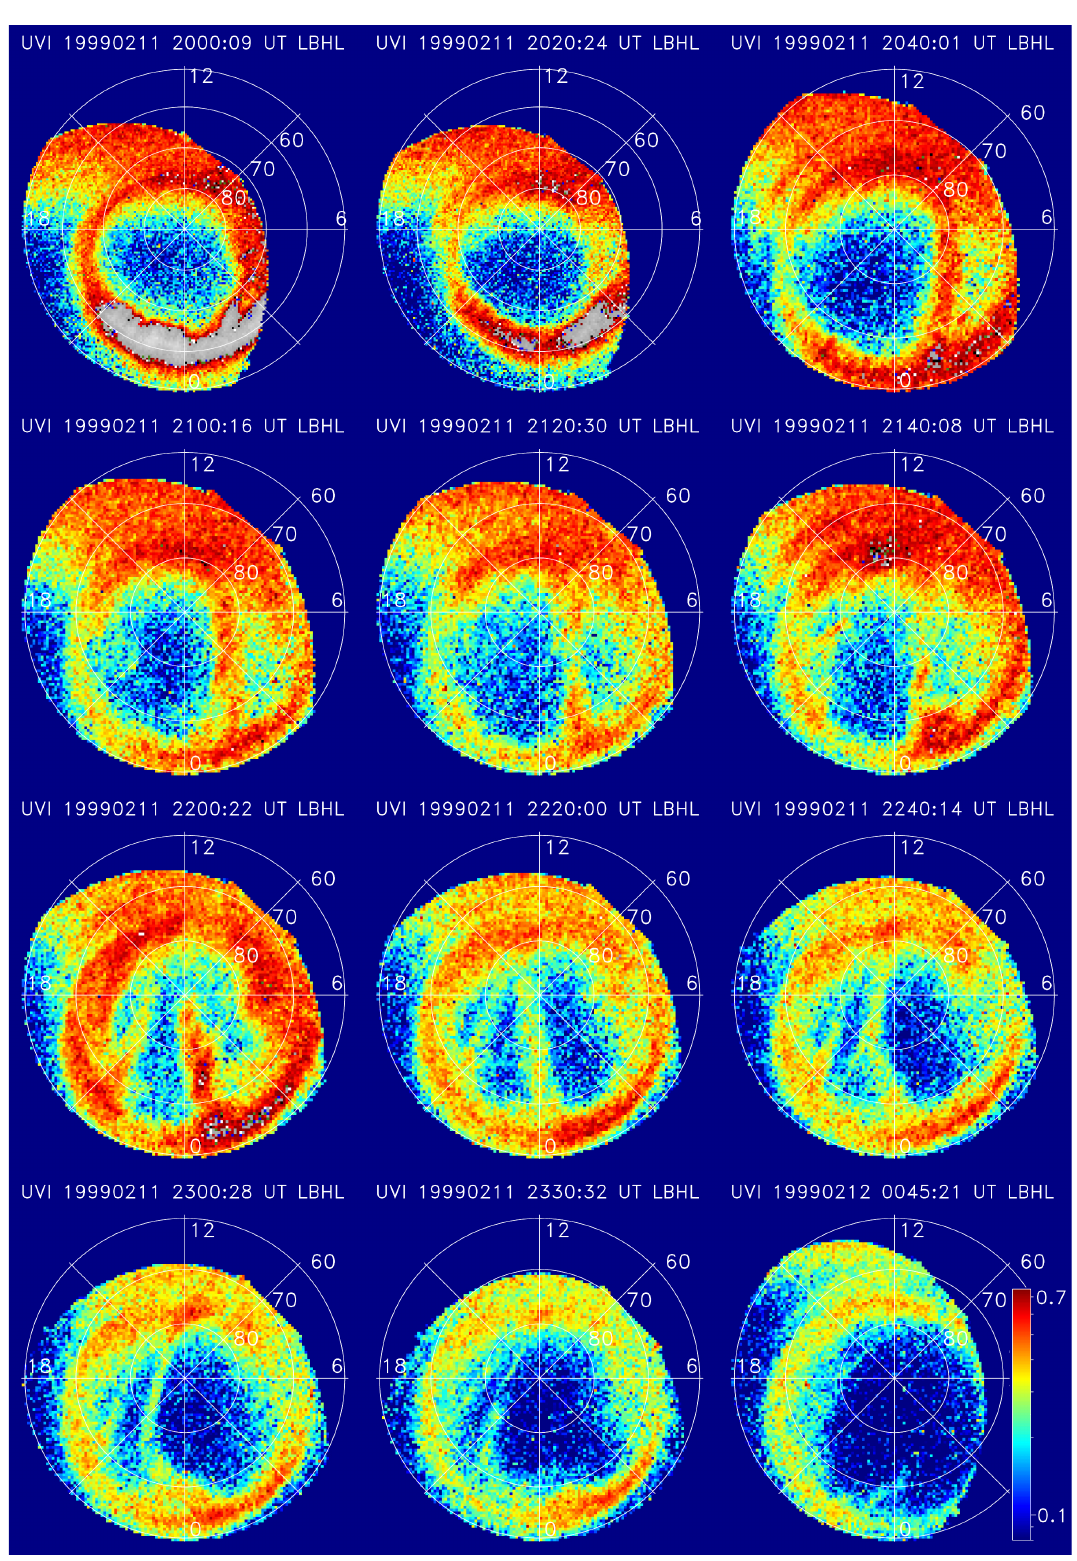
Fig. 3. For 11 February 1999, the Polar UV imager was in a mode that produced 36.8-s integration period images in the Northern Hemisphere using the LBHl filter and plotted in magnetic apex latitude and magnetic local time. False colour images of the aurora are shown, with a log colour scale extending from 0.08 to 0.75kR. See text for